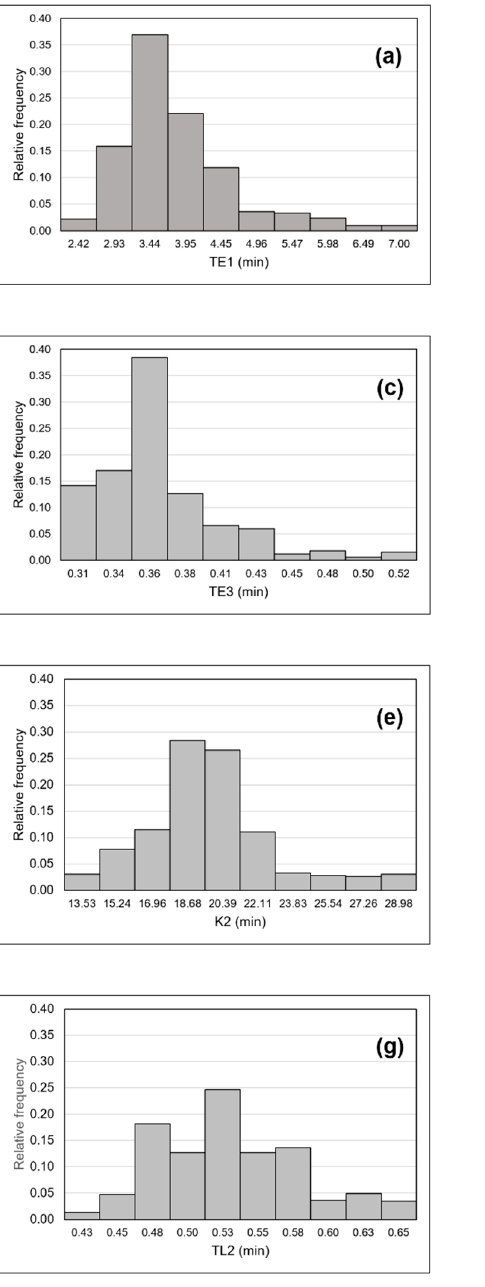
Figure 6. Histogram of the truck unit travel time data: ( a ) TE1; ( b ) TE2; ( c ) TE3; ( d ) K1; ( e ) K2; ( f ) TL1; ( g ) TL2; ( h ) TL3